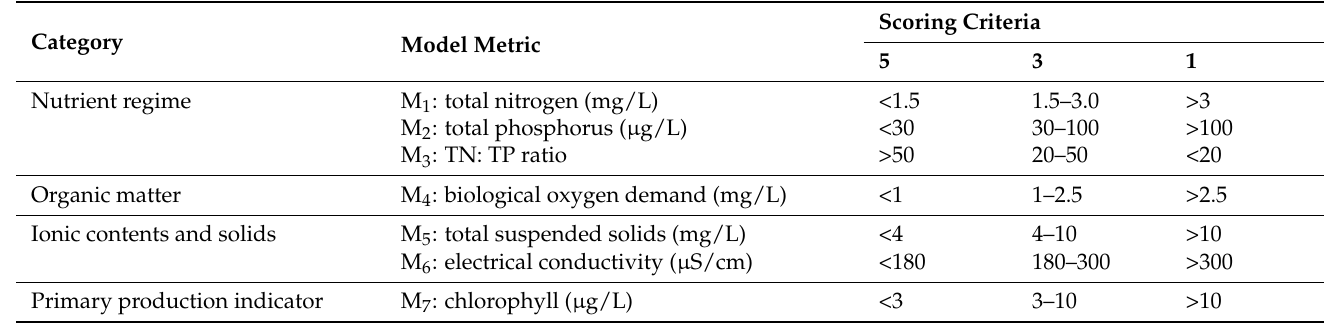
Table 1. Water pollution index (WPI) model and scoring criteria of seven